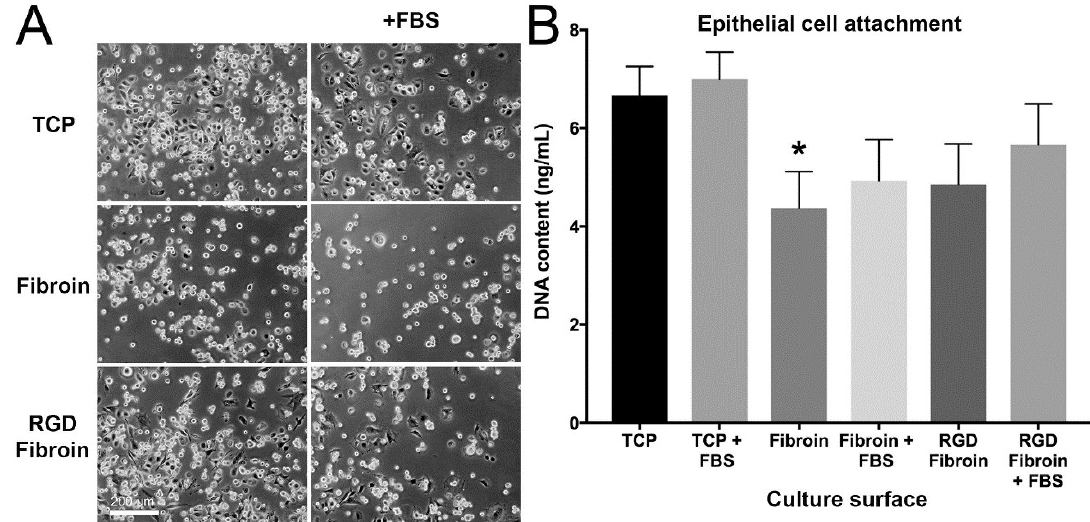
Figure 2. ( A ) Visual comparison of limbal epithelial cell attachment TCP, TCP coated with Fibroin (BMSF), or TCP coated with RGD-Fibroin. Cells were seeded at a density of 25,000 cells/cm² in 24-well culture plates and incubated for 90 min in the absence or presence of 10% ( v / v ) FBS in the culture medium. Phase contrast images display the typical appearance of cells after 90 min incubation followed by three rinses in phosphate-buffered saline. ( B ) Quantification of epithelial cell attachment via measurement of dsDNA content using the PicoGreen assay. Bars represent culture data derived from 4 unique donors. Asterisk indicates a significant difference ( p < 0.05) between Fibroin-coated TCP compared to TCP in serum-supplemented culture medium (+FBS) (Friedman test with Dunn’s multiple comparisons test; n = 4).